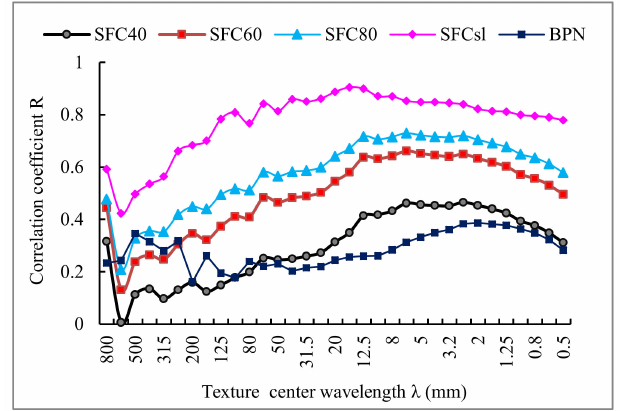
Figure 5. The correlation between friction values and road texture wavelength ( SFC 40 represents SFC at 40 km / h; SFC 60 represents SFC at 60 km / h; and SFC 80 represents SFC at 80 km /